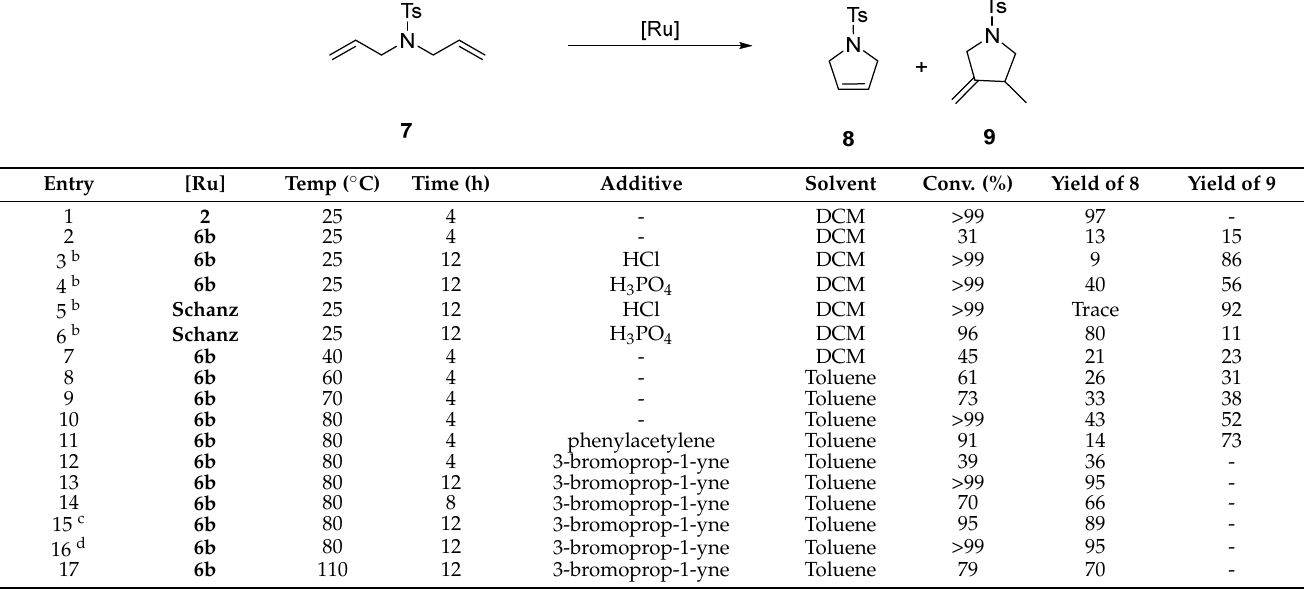
Table 1. Screening of RCM reaction conditions a .